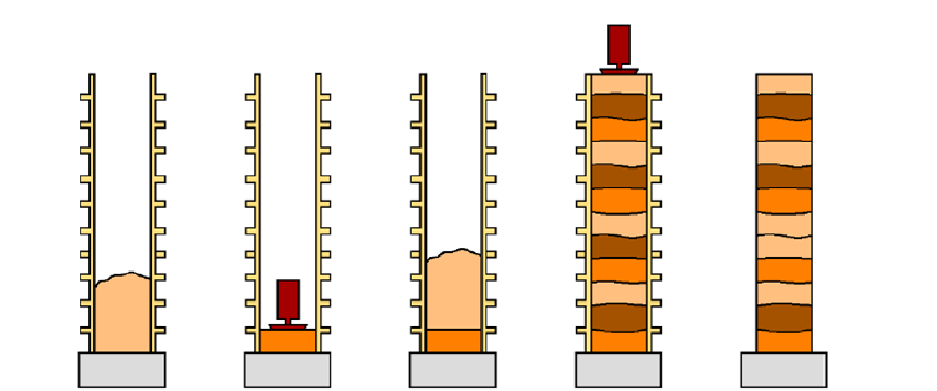
Figure 1. Procces of building earth wall.